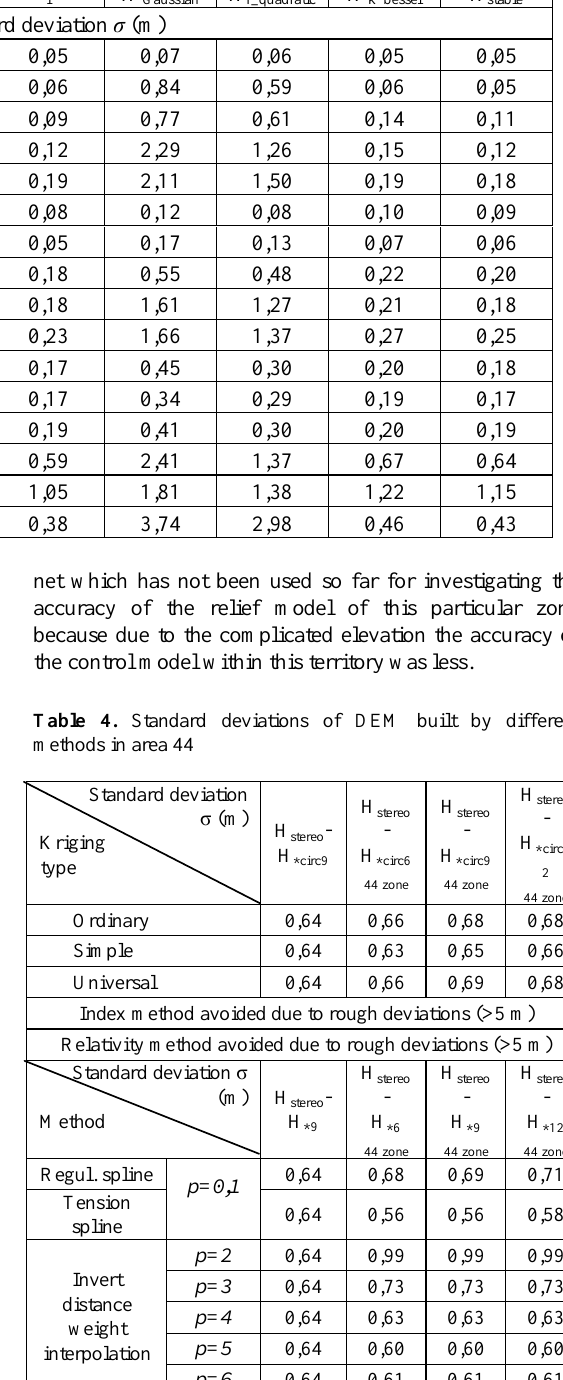
Table 3. Standard deviations of DEM built by different methods in separate areas The DTM was created with ordinary kriging method using 9 neighbouring points H stereo - H stereo - H stereo - Nr. H H - - stereo stereo H circular